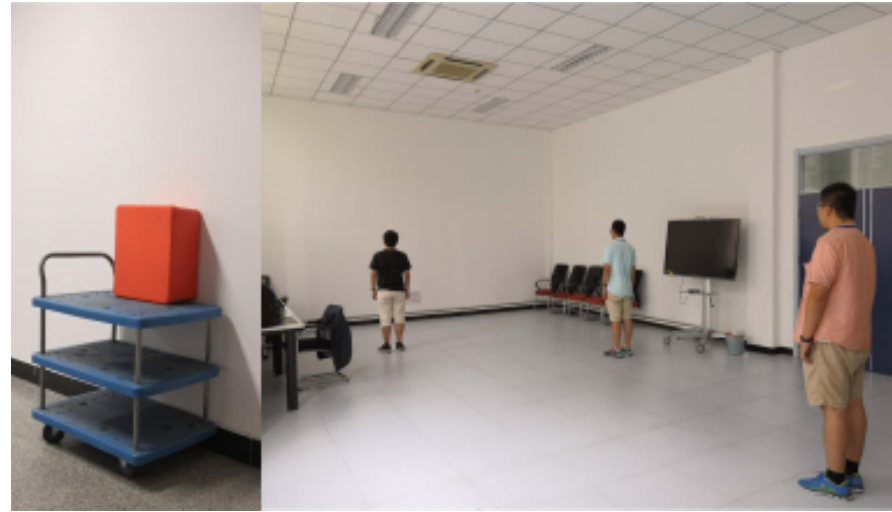
Figure 6. Measurement scenes for quasi-static human being detection in stationary operating mode.